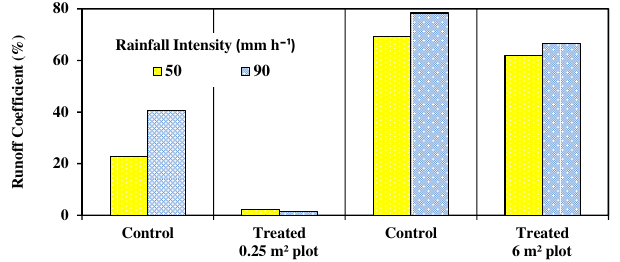
Figure 5. Average soil loss for the two study scales and the two rainfall